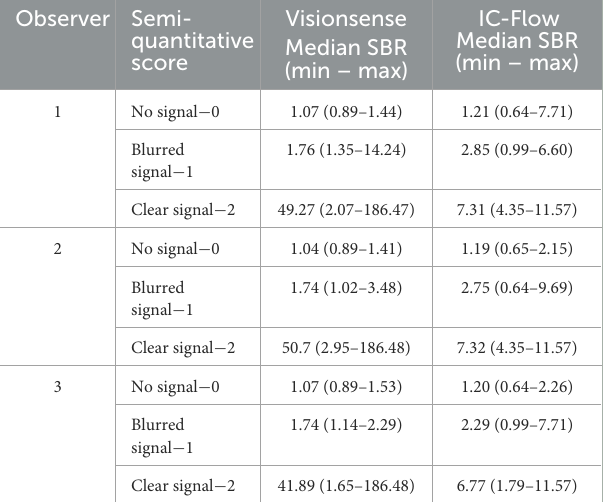
TABLE 3 Correspondence between semi-quantitative visual score and SBR (signal-to-background ratio) measurement, for the three observers. Observer Semi-